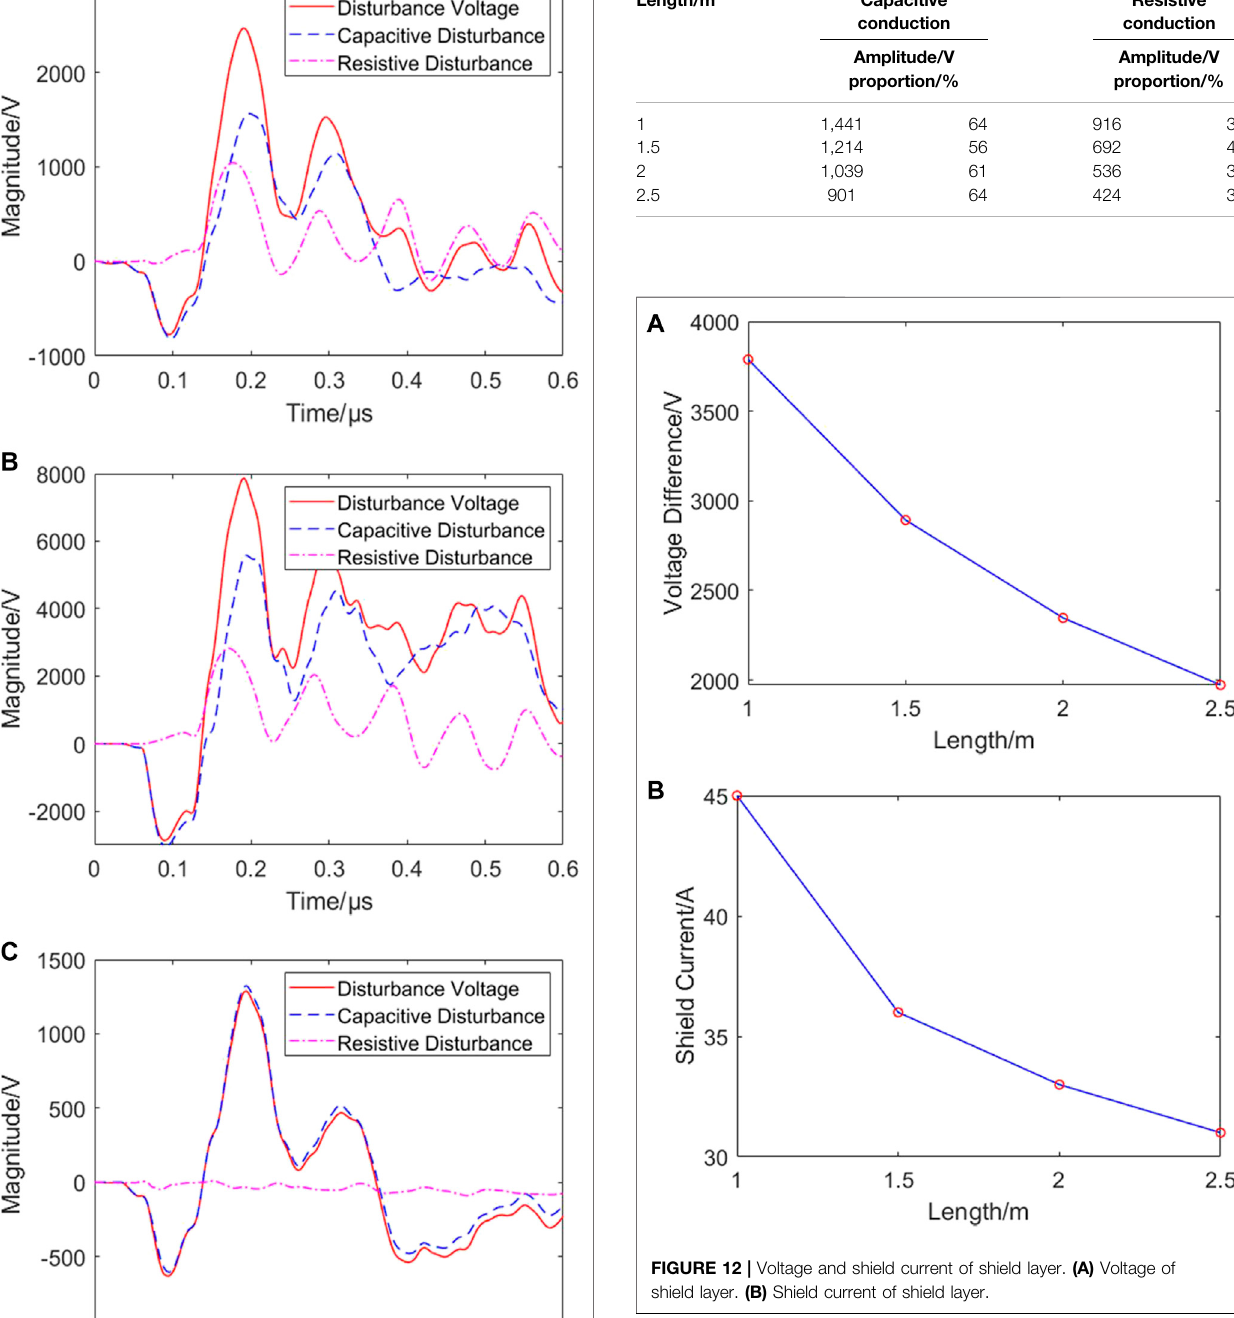
In Zhang et al. (2013), based on the 1000-kV GIS test circuit simulated in this study, UHV VFTO has measured the disturbance voltage of the secondary cable, and compared the disturbance voltage on the secondary cable core under three different grounding modes: grounding at both ends of the